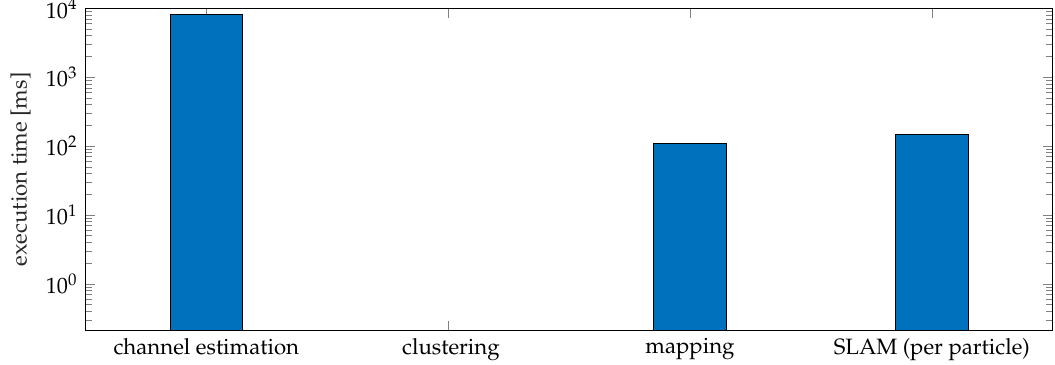
Figure 12. The execution times for each phase of the proposed